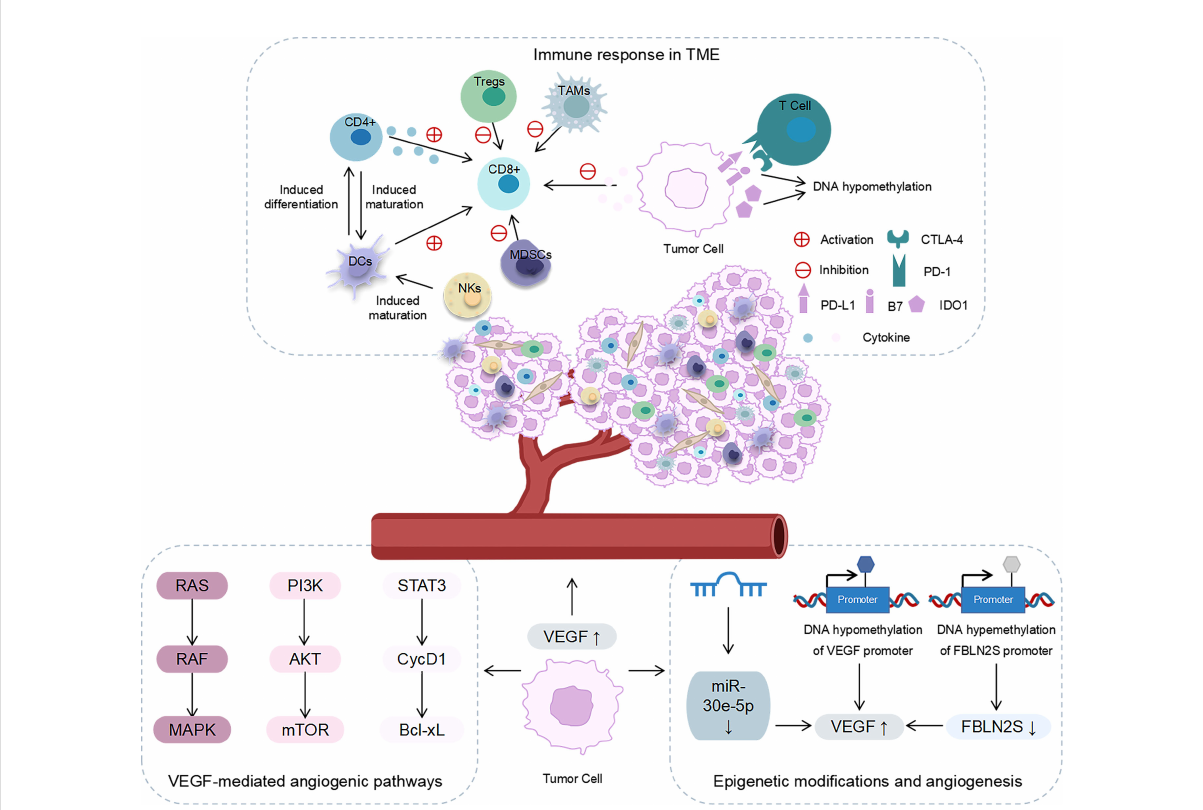
FIGURE 1 The role of angiogenesis and immune response in the TME. Immune response in the TME: NKs and CD4 + induced DC maturation; DCs promoted the activation of CD8 + T cells and induced CD4 + T cells to differentiate into antigen-speci fi c effector T cells; CD4 + secreted cytokines to activate CD8 + T cells; MDSCs, Tregs and TAMs inhibited the tumour-killing effect of CD8 + T cells; cancer cells released cytokines to inhibit T- cell proliferation and the effector function; PD-1/PD-L1 interaction inhibited the function of effector T cells; CTLA-4 binds to B7 ligands to inhibit T cell activation; IDO1 inhibited the function of T cells; the expression levels of CTLA-4 and IDO1 were regulated by DNA methylation. Angiogenesis in the TME: VEGF affected angiogenesis through RAS/RAF/MAPK, PI3K/AKT/mTOR, and STAT3/cycD1/Bcl-xL signalling pathways. Epigenetic modi fi cation affected the expression of VEGF and the angiogenesis in the